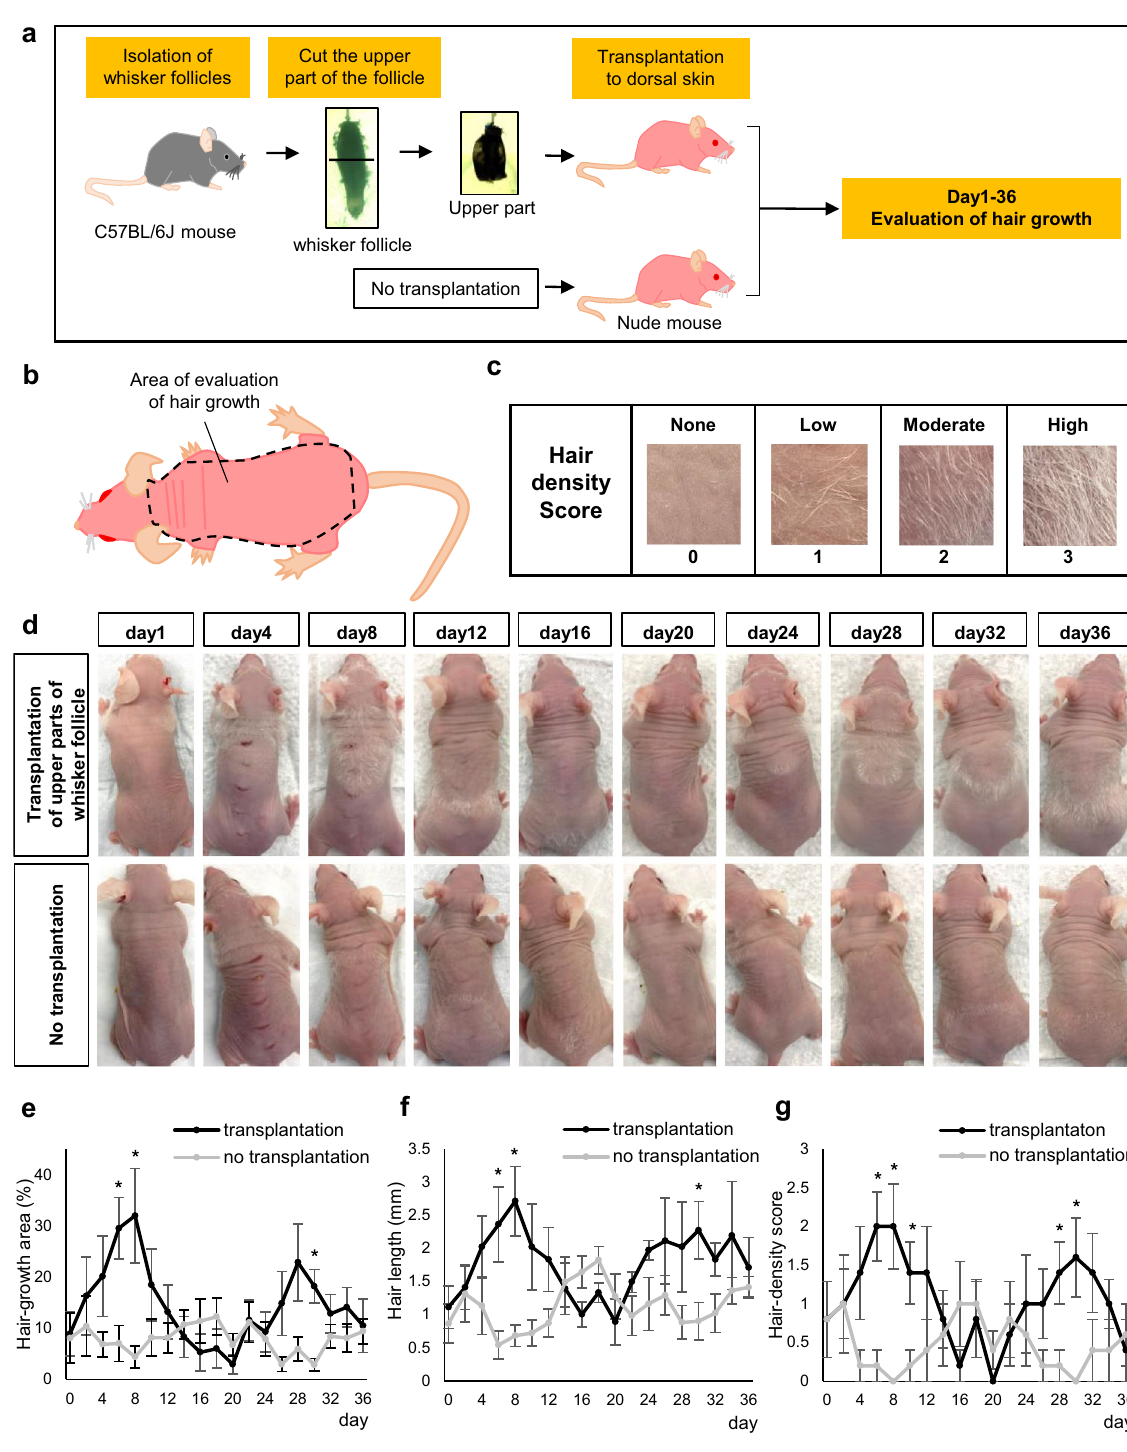
Figure 6. Hair growth of nude-mouse pelage follicles stimulated by transplanted upper part of whisker follicles from C57BL/6 J mice. ( a ) Schematic representation of experiment. ( b ) Schematic representation of the range of hair growth evaluation in nude mice. ( c ) Hair density score in nude mice. ( d ) Time course of hair growth of the nude mice transplanted with the upper part of whisker follicles from C57BL/6 J mice or nude mice without transplantation. ( e ) Time course of hair-growth area of transplanted mice or non-transplanted control mice (n = 5 for each group). ( f ) Time course of hair length of mice transplanted with the upper part of whisker follicles from C57BL/6 J mice or non-transplanted control mice (n = 5 for each group). ( g ) Time course of hair density score of transplanted mice or non-transplanted control mice (n = 5 for each group). Two-way ANOVA followed by Bonferroni’s multiple comparisons post-hoc test was applied for all statistical analyses in this figure. Values are expressed as the mean ± SEM. Significance was indicated as *P < 0.05. Source data are provided as a Source Data